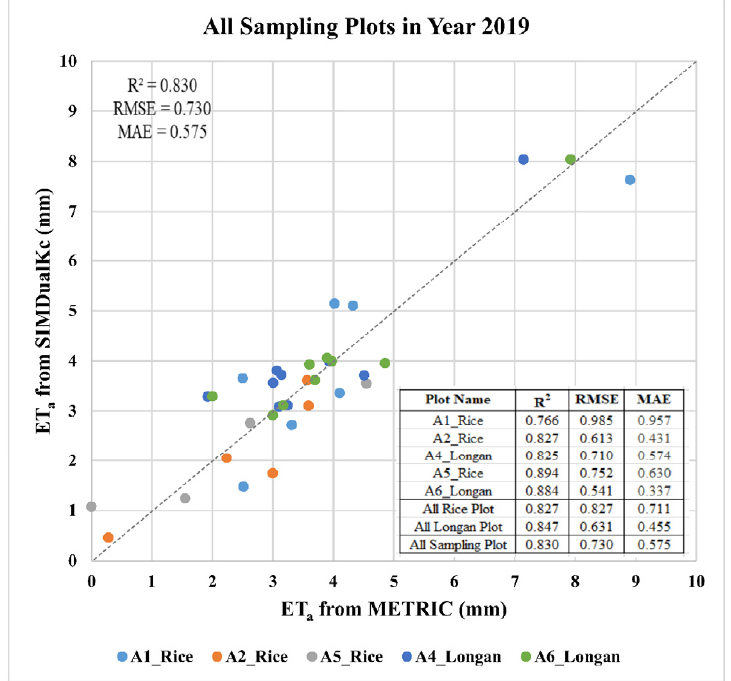
Figure 5. Correlation between the actual evapotranspiration ( ET a ) values derived from the mapping evapotranspiration at high resolution with internalized calibration (METRIC) model and SIMDualKc at the satellite acquisition date for all sample plots from the testing area in the Chom Thong District, Chiang Mai Province, downstream of the Muang Luang Weir, Thailand. The cumulative ET a values derived from METRIC and SIMDualKc for each sample plot covering the dry season in 2019 were used to assess the accuracy of the seasonal ET a (Table 5). Generally, rice was ready to be harvested 120 days after planting. Furthermore, the planting dates of the rice plots in the A2_Rice and A5_Rice plots did not significantly differ (Table 5). Both rice plots were planted in October and harvested from late January to mid-February. The A1_Rice plot was planted later than the other two plots. It was planted in mid-January and harvested in mid-May, with peak growth in April. We also found that ET r was generally higher during March and May than in other months. Therefore, the cumulative ET a of the rice plot in A1_Rice in the dry season was higher than that of the rice plots in A2_Rice and